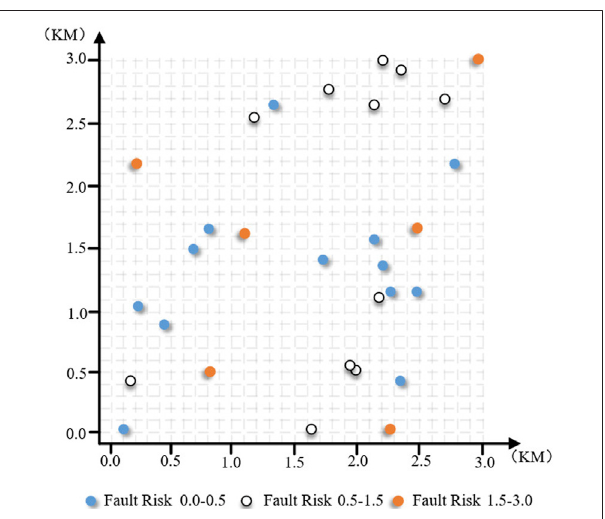
FIGURE 4 | Production and consumption of consumer con fi guration